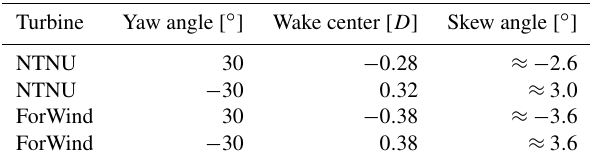
Table 2. Wake center location as computed by the approach de- scribed in Sect. 2.2 with corresponding skew